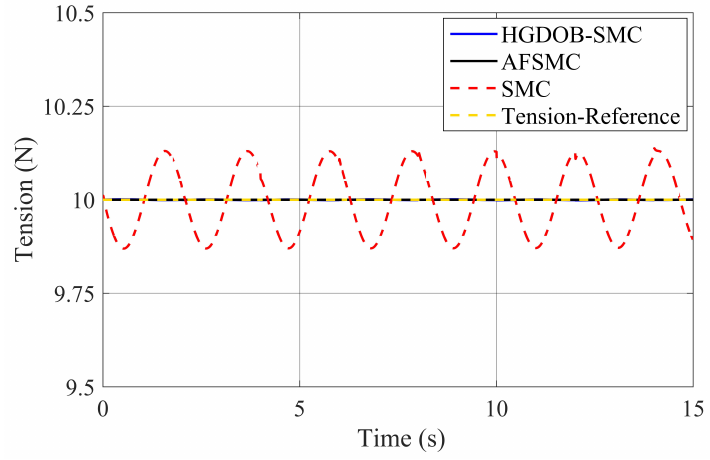
Figure 8. Tension